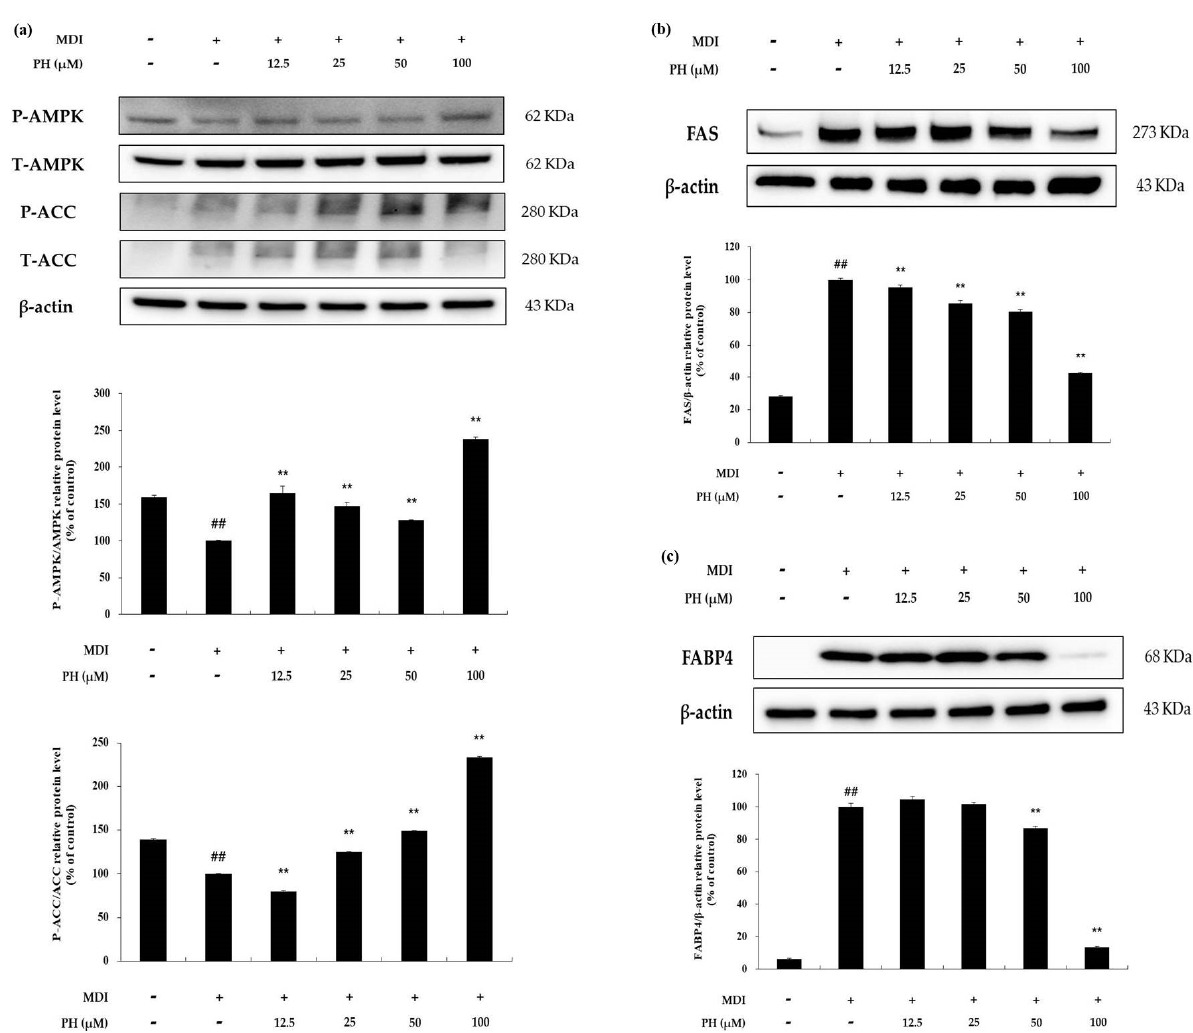
Figure 6. Effect of PH on the AMPK signaling pathway. Adipocyte differentiation was induced in post-confluent cells using MDI differentiation medium, followed by treatment with the indicated concentrations of PH for 6 days (AMPK, ACC) and 8 days (FAS, FABP4). ( a ) Results of the Western blotting analysis and the protein levels of P-AMPK/AMPK, P-ACC/ACC, and β -actin. ( b ) Results of the Western blotting analysis and the protein levels of FAS and β -actin in 3T3-L1 adipocytes. ( c ) Results of the Western blotting analysis and the protein levels of FABP4 and β -actin in 3T3-L1 adipocytes. The relative protein levels of P-AMPK/AMPK, P-ACC/ACC, FAS/ β -actin, and FABP4/ β -actin are presented as the mean ± standard deviation of three independent measurements using the ImageJ program. The relative protein levels are expressed as percentages relative to the protein levels of control cells treated with MDI alone. ** p < 0.01 indicates significant differences versus the MDI-only control. ## p < 0.01 indicates significant differences versus an untreated control.